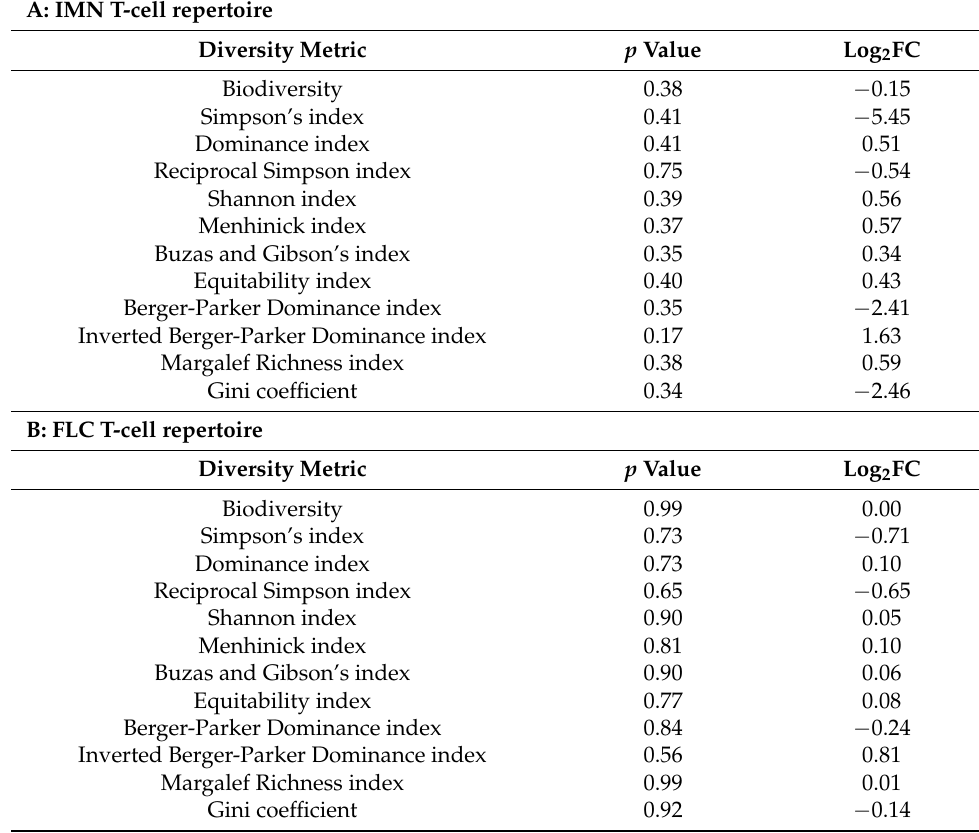
Table 1. (A), IMN T-cell repertoire; (B) FLC T-cell